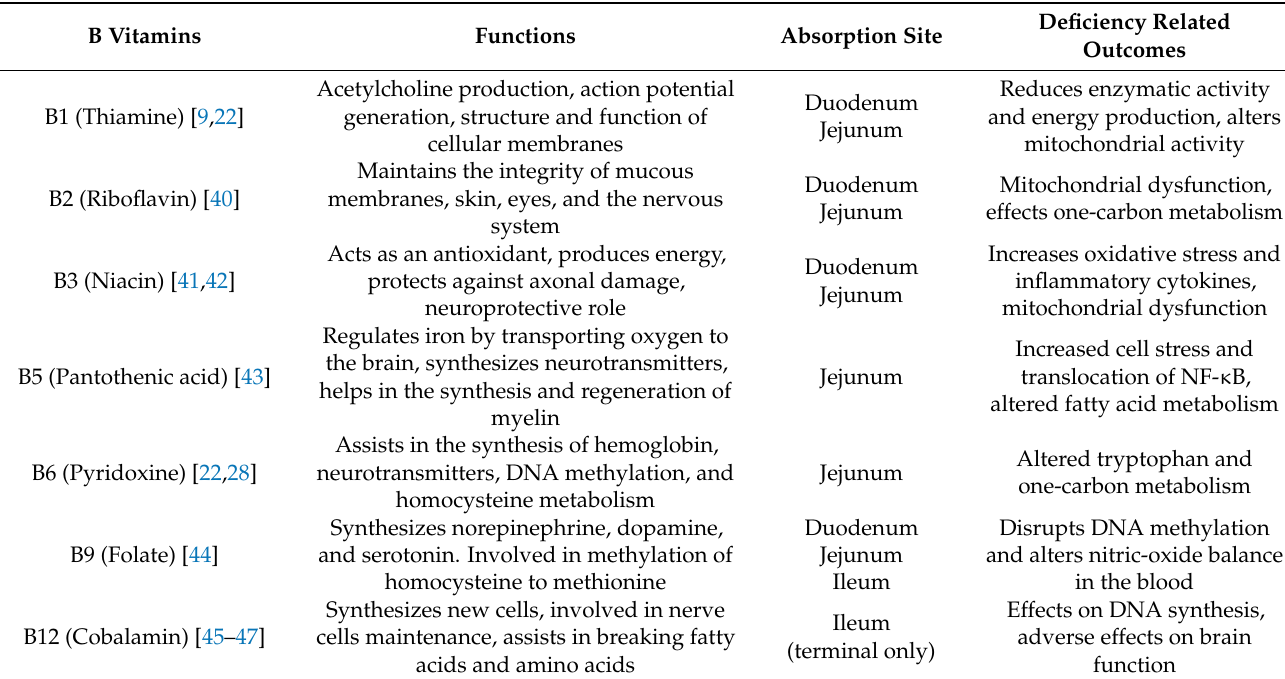
Table 1. The functions of B vitamins, site of absorption, and deficiency related outcomes. B